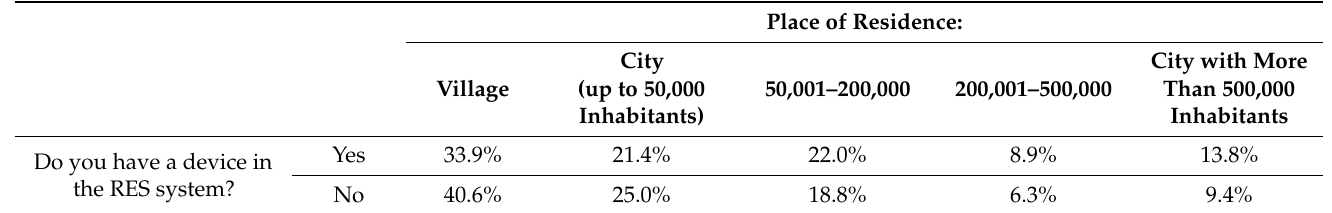
Table 2. Distribution of the size of the place of residence in terms of having RES. Sample n = 400.